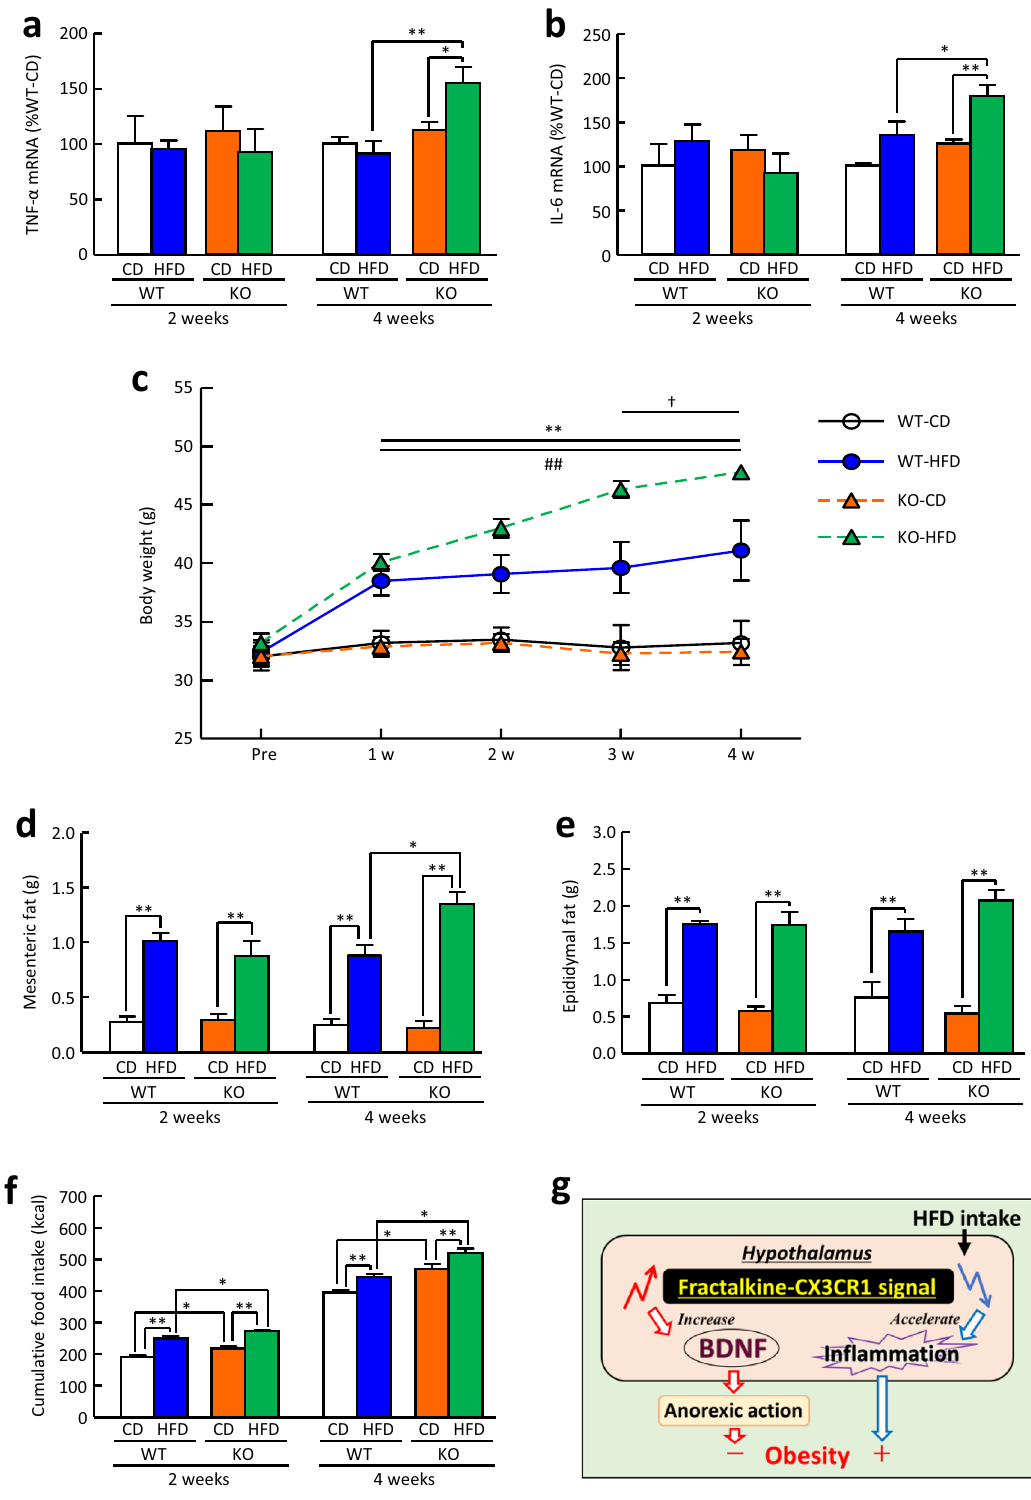
Figure 7. Changes in TNF-α and IL-6 mRNA expression in the hypothalamus and cumulative food intake and metabolic parameters of CX3CR1-deficient mice fed a HFD. ( a ) TNF-α and ( b ) IL-6 mRNA expression in the hypothalamus of CX3CR1-deficient mice fed a HFD for 2 and 4 weeks. ( c ) Body weight, ( d ) mesenteric fat, and ( e ) epididymal fat in CX3CR1-deficient mice fed a HFD for 2 and 4 weeks. ( f ) Cumulative food intake for 2 and 4 weeks in CX3CR1-deficient mice fed a HFD. ( g ) Proposed mechanisms of food intake regulation by fractalkine-CX3CR1 signalling. WT: wild-type mice, KO: CX3CR1-deficiet mice. Results are expressed as mean ± SEM for 4–11 mice. Significant difference in ( a ), ( b ), ( d ), ( e ), and ( f ): * p < 0.05, ** p < 0.01. Significant difference in c: ** p < 0.01; WT-HFD compared with WT-CD, ## p < 0.01; KO-HFD compared with KO-CD, † p < 0.05; KO-HFD compared with